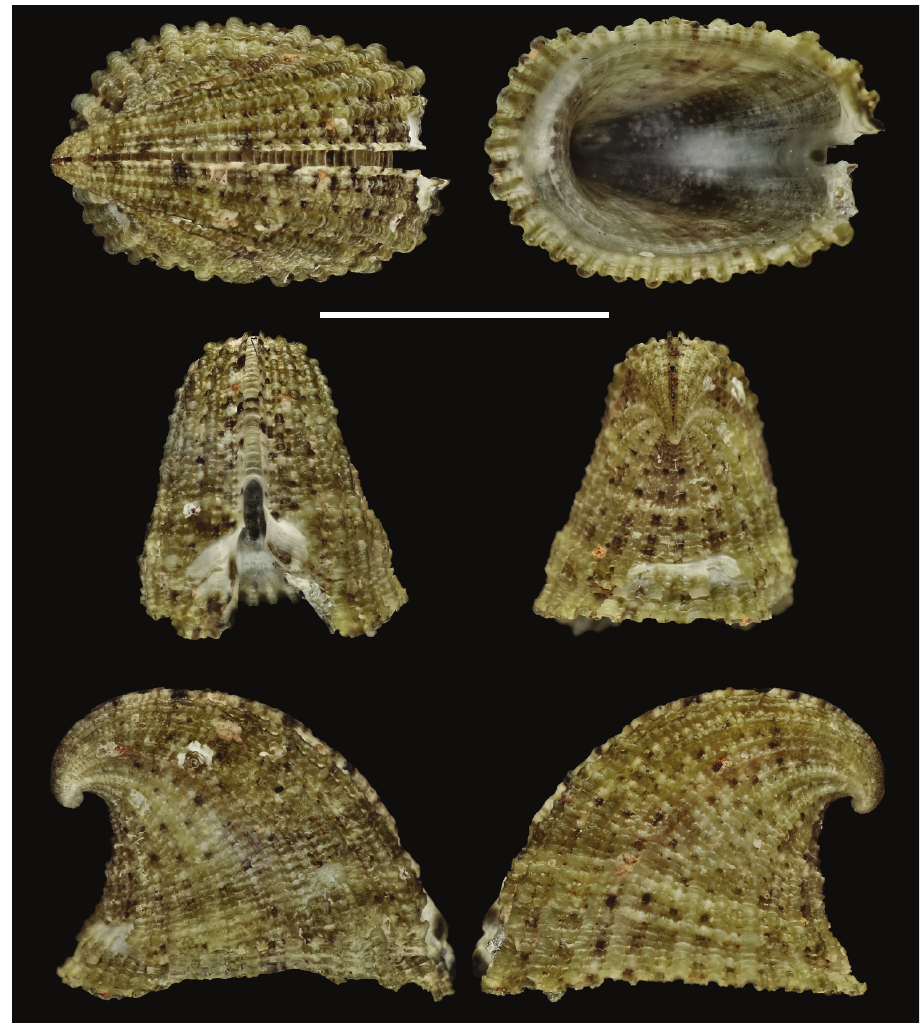
Figure 5. Emarginula connelli Kilburn, 1978. Holotype T2199/NMSA-MOL 0A5762. Scale bar: 5